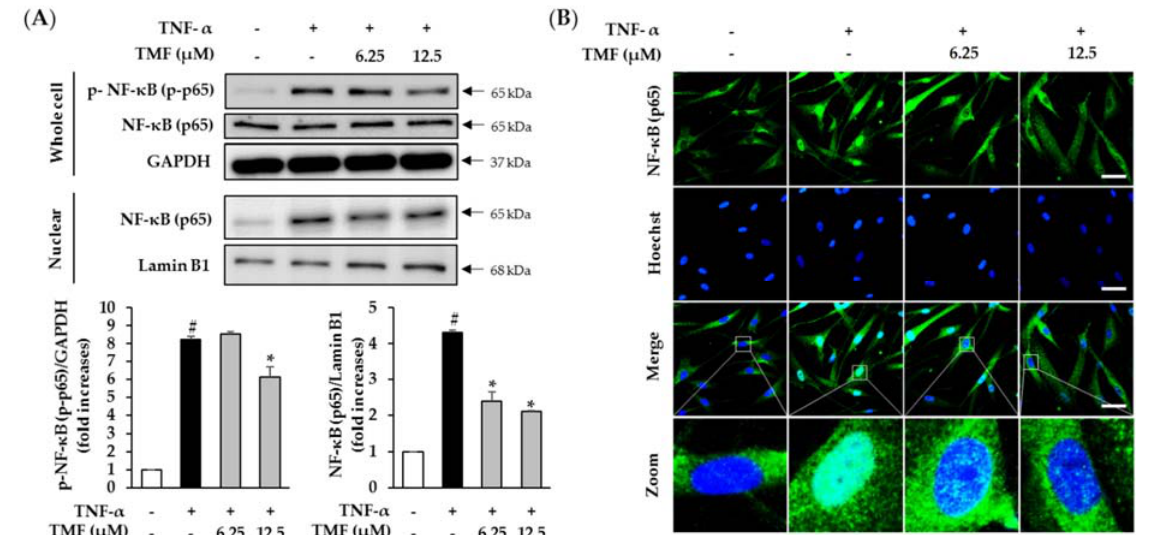
Figure 11. Effect of TMF on TNF– α –induced phosphorylation and translocation of NF- κ B in HDFs. ( A ) Expression and phosphorylation of NF– κ B (p65) was determined by immunoblotting. The data are expressed as mean ± SEM ( n = 3). # p < 0.05 compared to non-treated group and * p < 0.05 compared to TNF- α -treated group. ( B ) Translocation of NF- κ B (p65) from the cytoplasm to nuclear was visualized using immunofluorescence staining (40 × magnification, 100 µ m scale bar). Abbreviations: TMF, 5,7,4 (cid:48) -trimethoxyflavone, and TNF- α , tumor necrosis factor